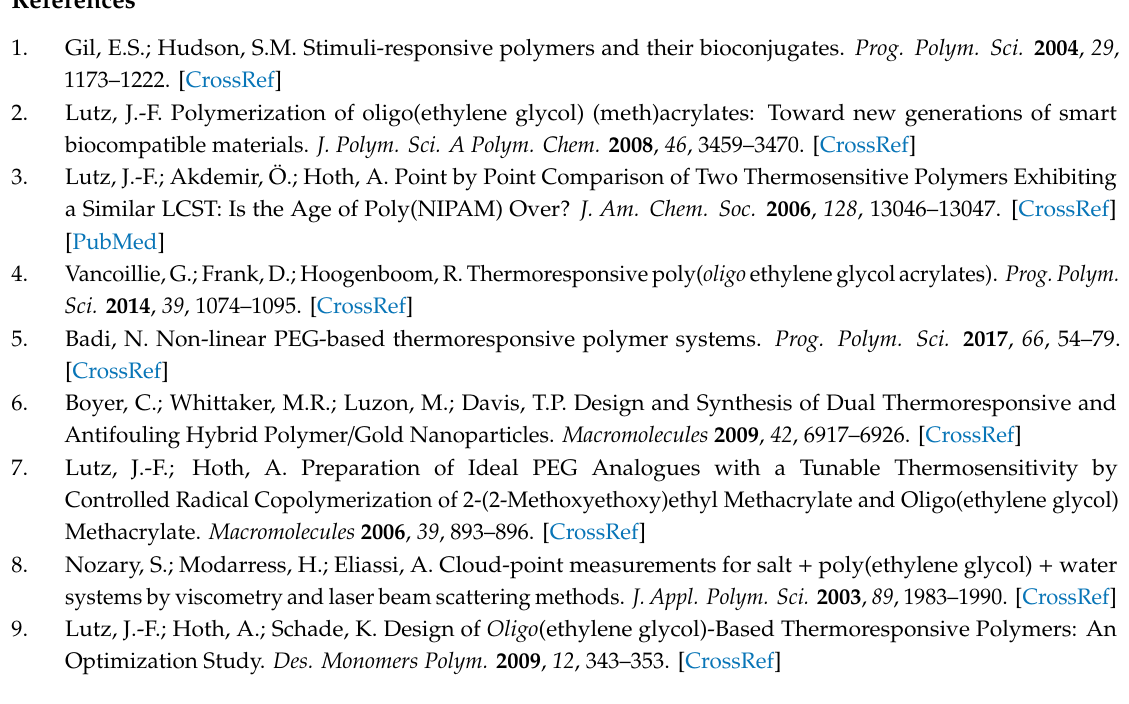
Figure S1: E ff ect of temperature on oil adsorption by PTEGA gel. Data Availability: The datasets analysed during the current study are available from the corresponding author on reasonable